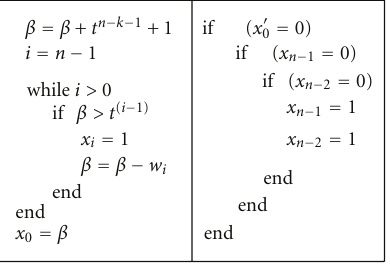
Figure 3: Enumerative encoding for ( k even 1 , k odd 1 , k ) codes.